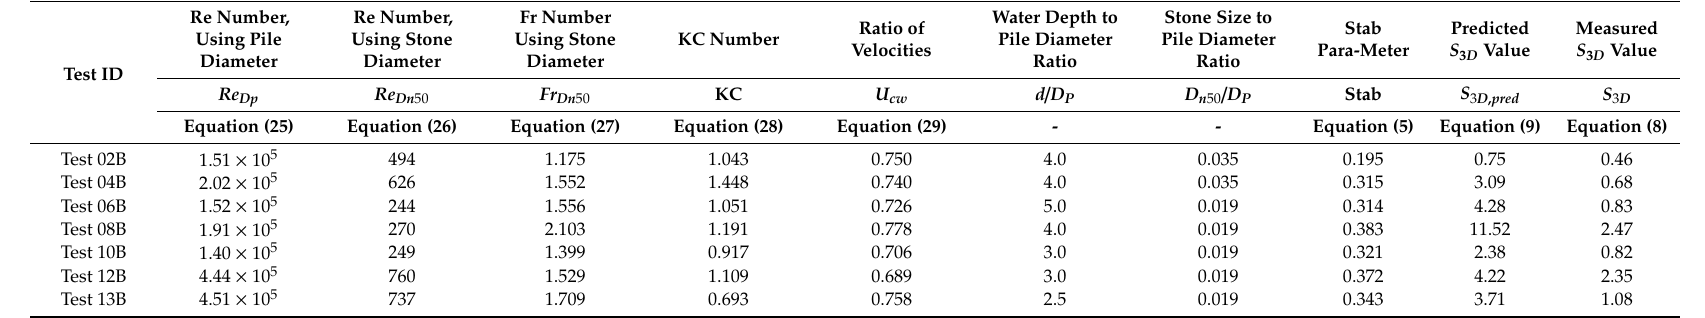
Table 5. Dimensionless parameters for irregular wave